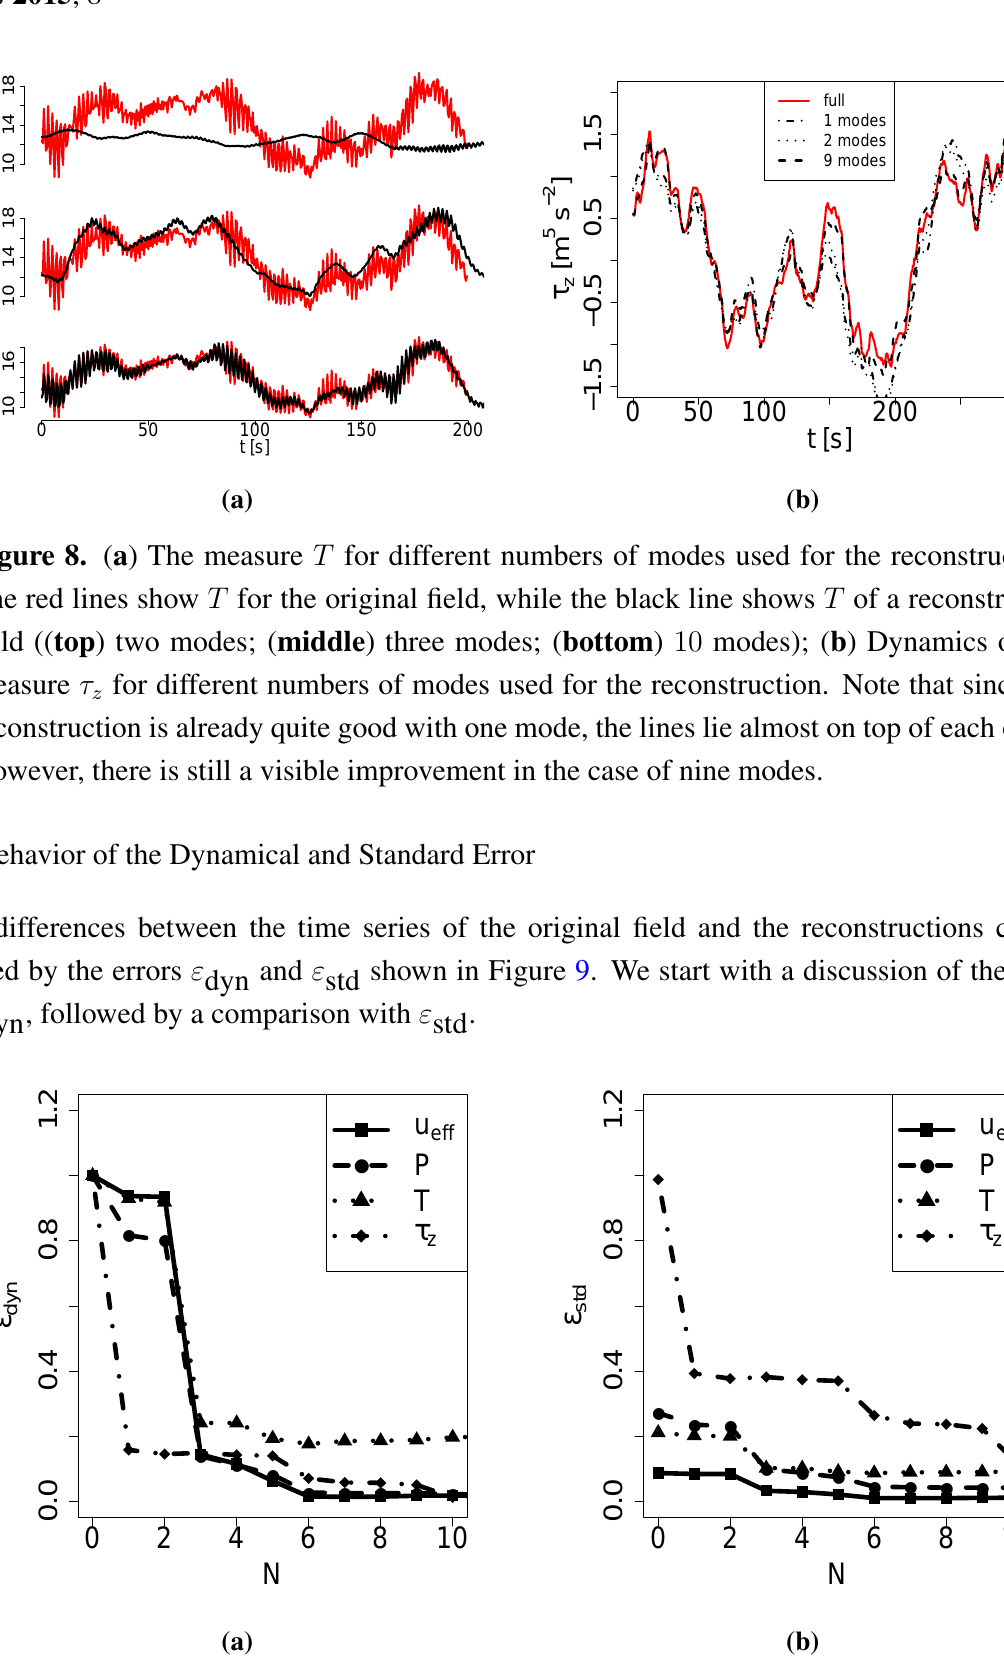
Figure 9. ( a ) Dynamical and ( b ) standard error for different measures versus the number N of modes used for reconstruction. N = 0 corresponds to a reconstruction with the mean field